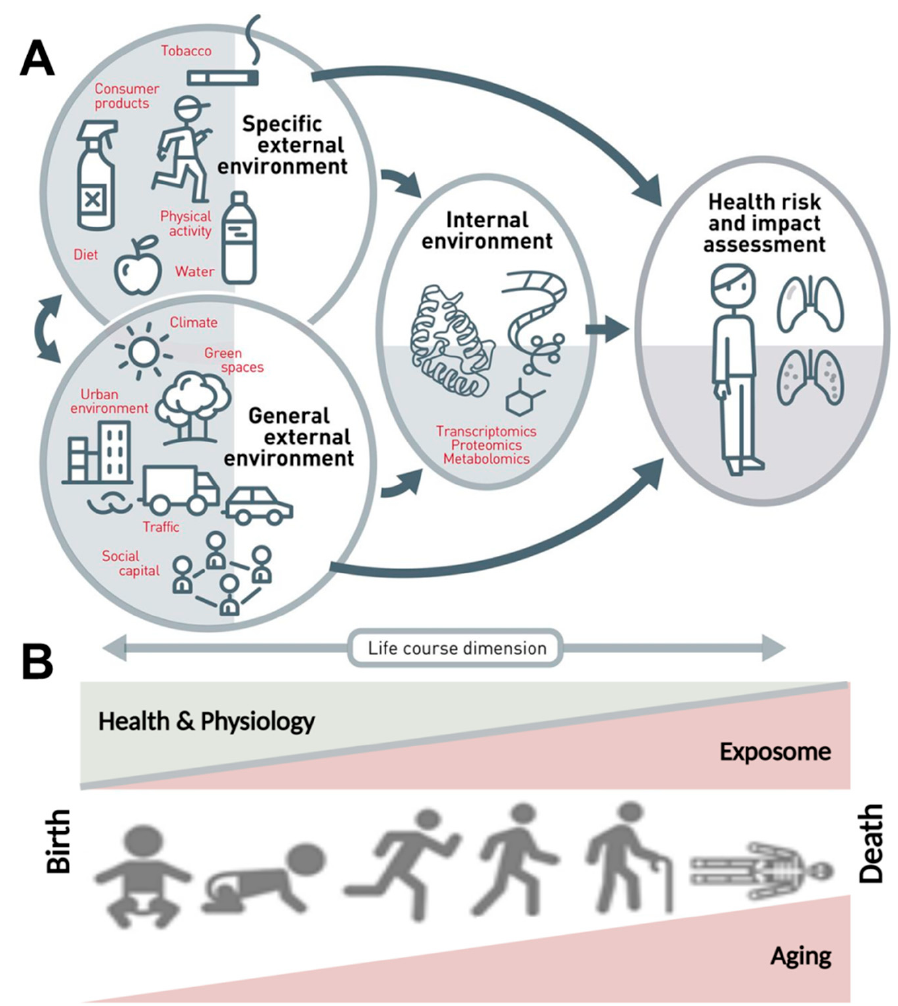
Figure 1. The exposome concept. ( A ) The exposome comprises the totality of a person’s external and internal exposures, from birth to death. ( B ) The external exposures and their internal exposure-related biochemical changes accumulate steadily over the aging process and lead to altered health risks. Adapted from Vrijheid et al. [2] (upper part, Copyright © 2021, BMJ Publishing Group Ltd. and the British Thoracic Society) and Misra [3] (lower part, under the terms of the Creative Commons Attribution License (CC BY), Copyright © 2021 Misra) with permission.